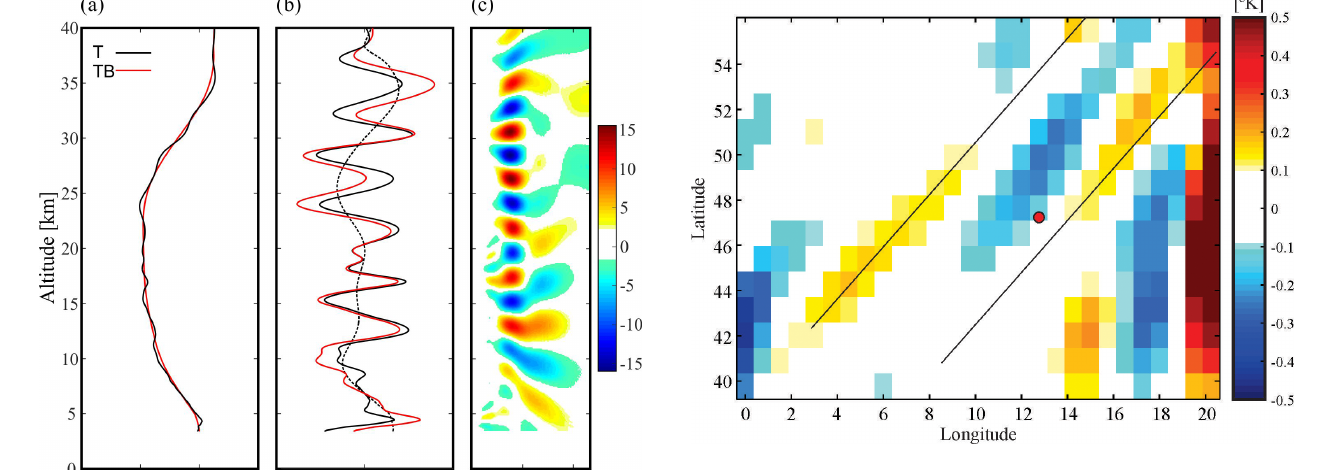
Figure 7. ERA-Interim δT data corresponding to the case study in the Alps region. The red dot indicates the mean TP